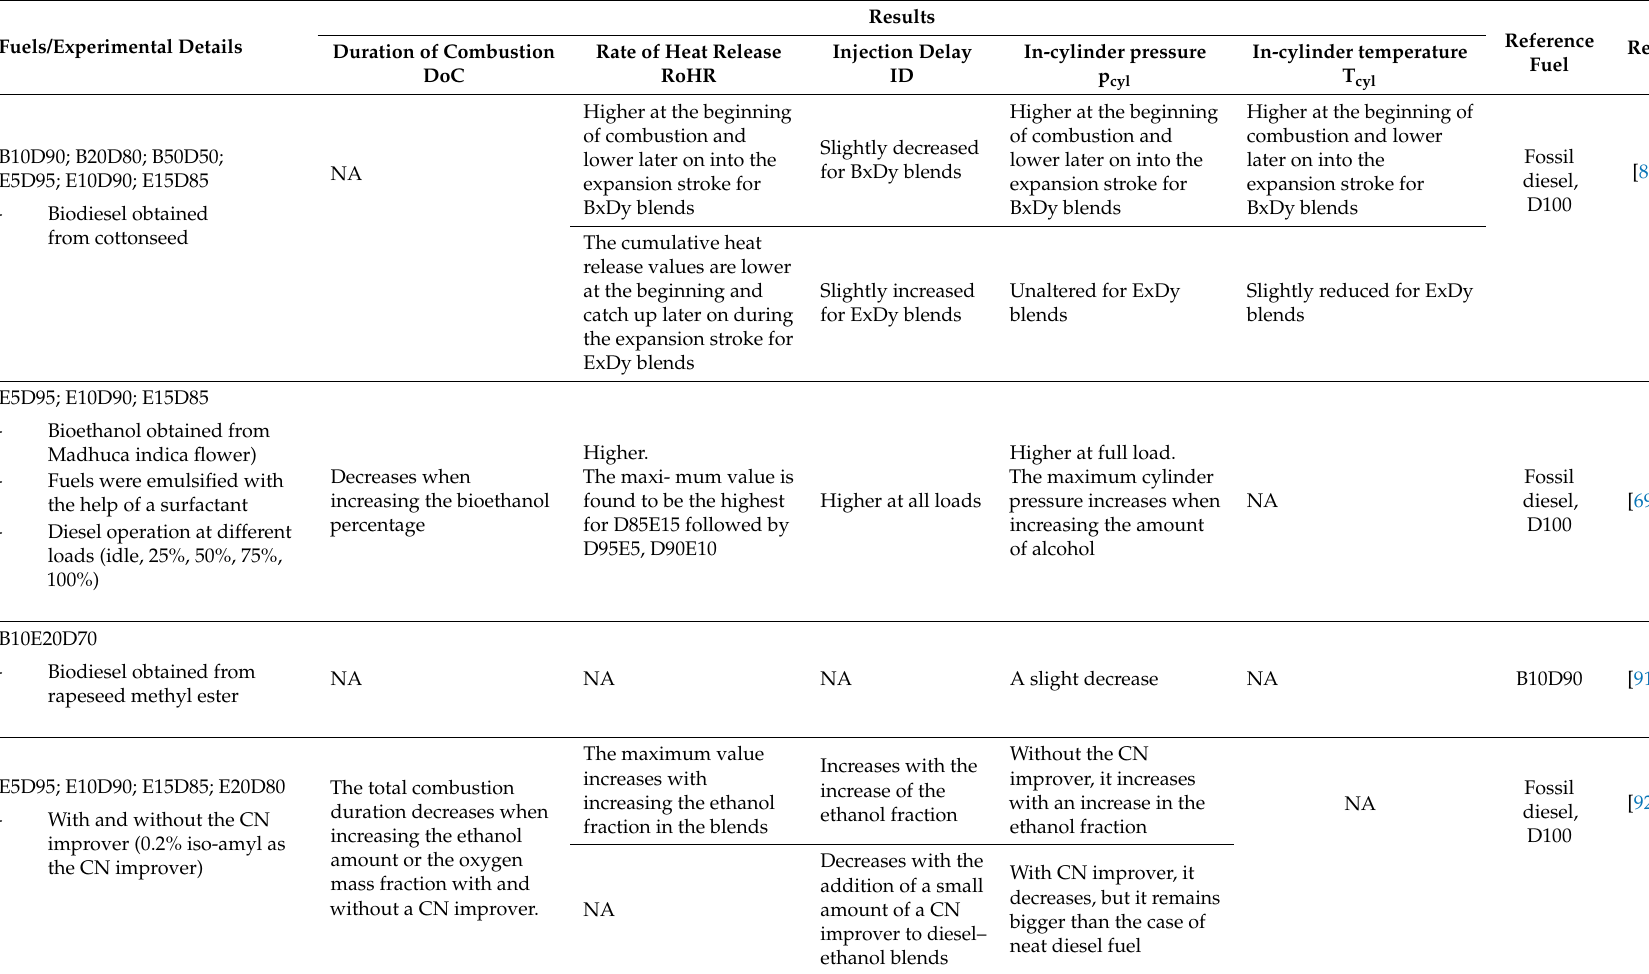
Table 7. Combustion characteristics (in this table, NA means “not available”; equally, being about blends, fuels are designated in the following manner: BxDy/EyDx/BxEyDz; B, E, D stand for biodiesel, ethanol, and diesel, respectively, while x, y, z stand for the corresponding